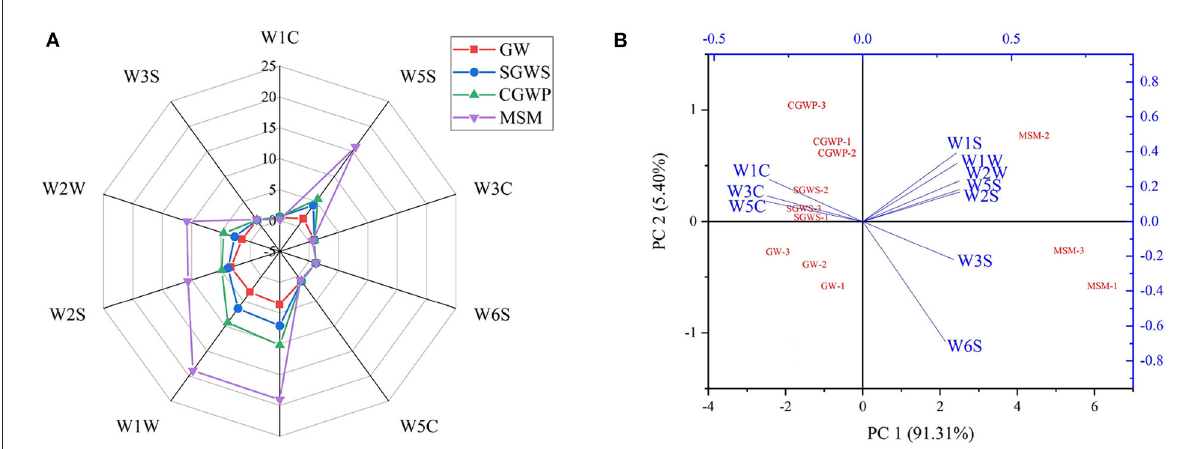
FIGURE4 The response signals of electronic nose (E-nose) detection of volatile compounds. (A) Radar plot of the response by electronic nose for GW, SGWS, CGWP, and MSM. (B) Biplot loadings and scores (PCA) of E-nose for different processes of nian zhuan. The sensors include W1C (aromatic compounds), W1W (sulfur compounds, terpenes), W1S (methane, broad range of compounds), W2W (aromatics and organic sulfur compounds), W3C (ammonia, aromatic compounds), W2S (broad range, alcohols), W5C (alkanes and aromatics), W3S (methane and aliphatic compounds), W6S (hydrocarbons) and W5S (nitrogen